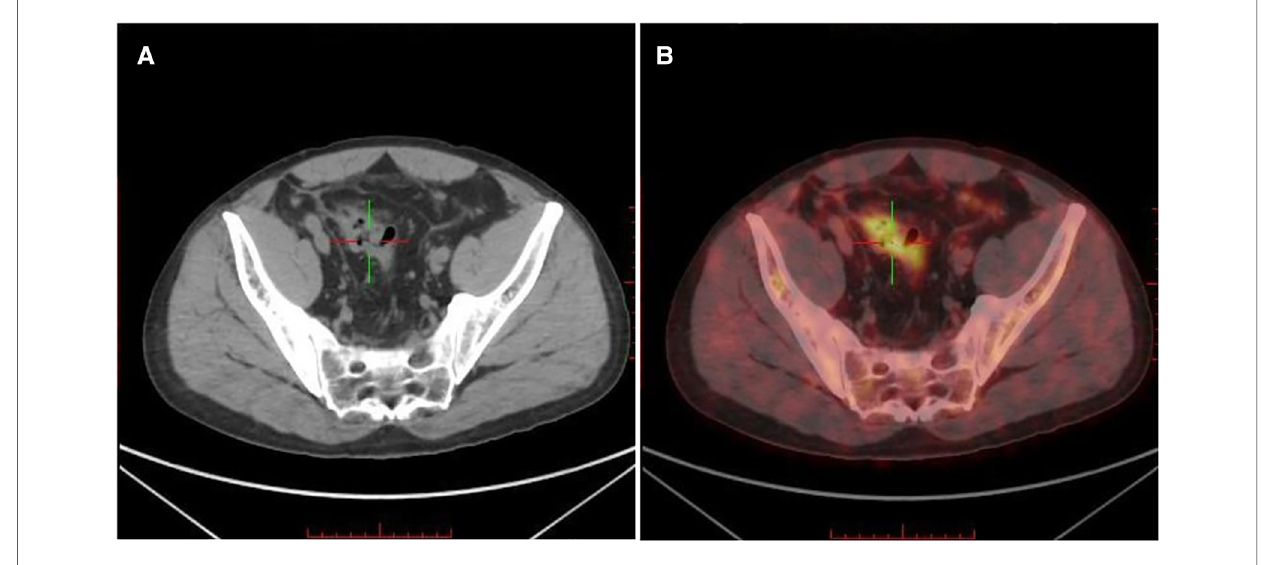
FIGURE 3 Positron emission computed tomography (PET-CT) of the lesion. ( A ) PET-CT showed a thickening of the sigmoid canal wall; ( B ) increased FDG uptake and a maximum SUV of approximately